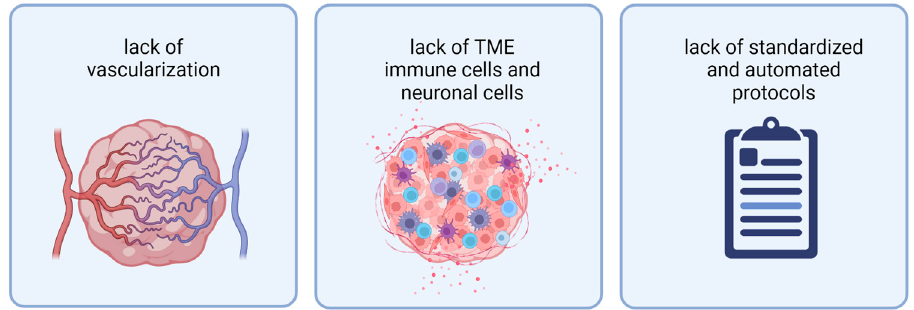
Figure 2. Current organoids face three limitations: from left to right: lack of vascularization, lack of TME immune cells and neuronal cells, and lack of standardized and automated protocols for organoid generation. Abbreviations: TME: tumor microenvironment. Created with BioRender.com (accessed on 7 November 2022).